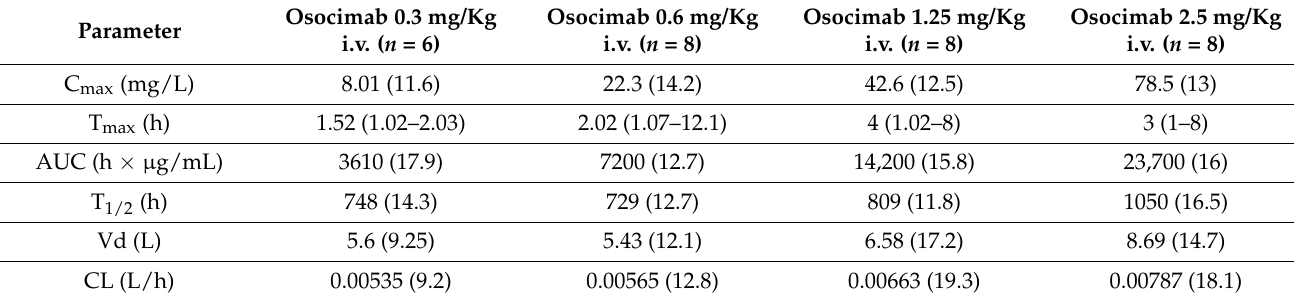
Table 4. Plasma pharmacokinetic parameters of osocimab. Geometric Mean (Geometric Mean CV%) osocimab PK parameters. For T max , data are presented as median (min-max). Data are from Thomas D. et al. [24]. C max : Maximum plasma concentration; T max : time to reach C max . AUC: area under the curve; T 1/2 : half-life time; Vd: volume of distribution; CL: